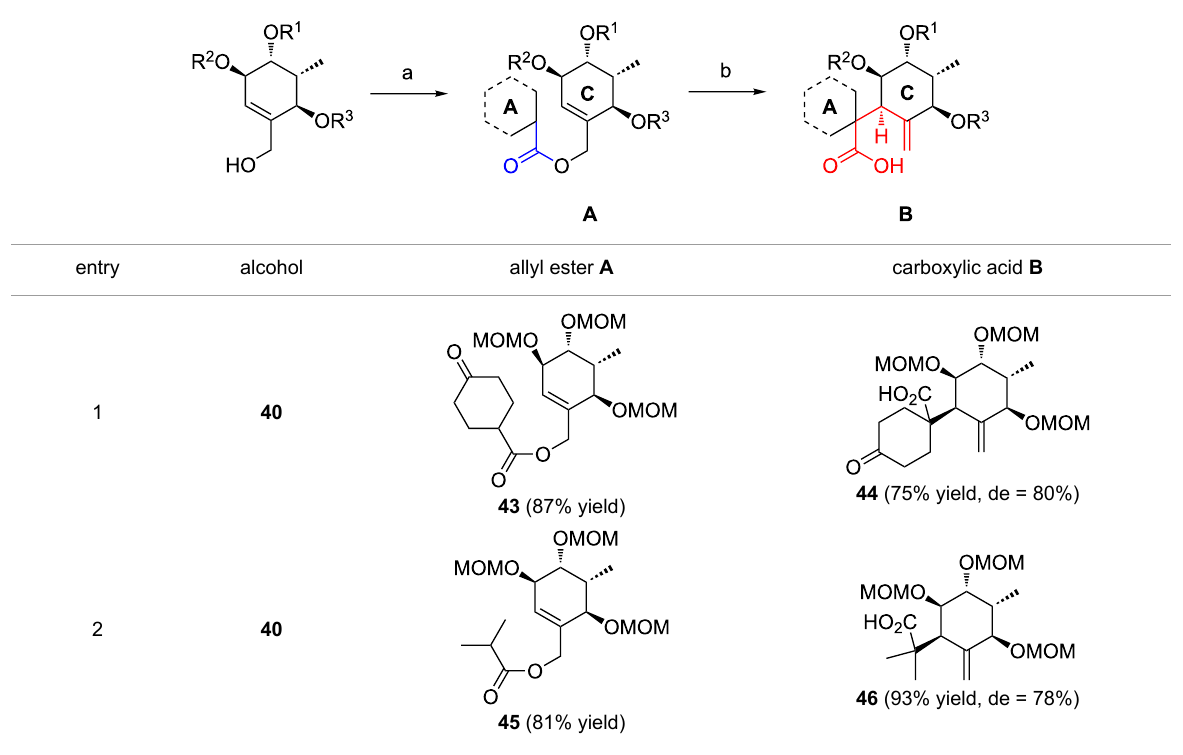
Table 2: Esterification of alcohols 40 , 41 and 42 and Ireland–Claisen rearrangement. Reagents and conditions: a) EDC·HCl, DMAP, carboxylic acid,